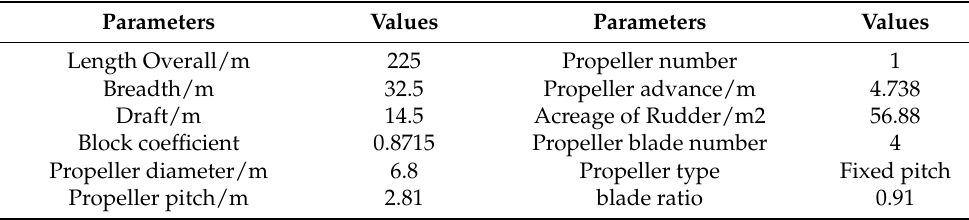
Table 2. Principal particulars and manoeuvrability characteristics of OS.